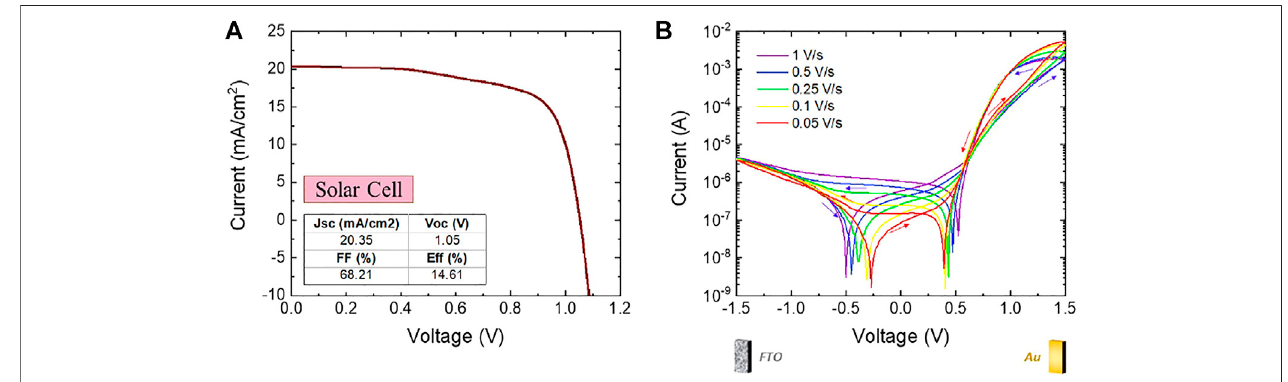
FIGURE 6 | (A) Current – voltage characteristic of the FTO/c-TiO 2 using a halogen- 2 /m-TiO 2 /MAPI/spiro-OMeTAD/Au solar cell was measured at 100 mW/cm based solar simulator calibrated with a silicon photodiode. The inset table shows the characteristic parameters. Here, the photocurrent is drawn positive. (B) Current − voltage characteristics were measured under a dark condition for 5 different scan rates. Arrows indicate the sweep direction.